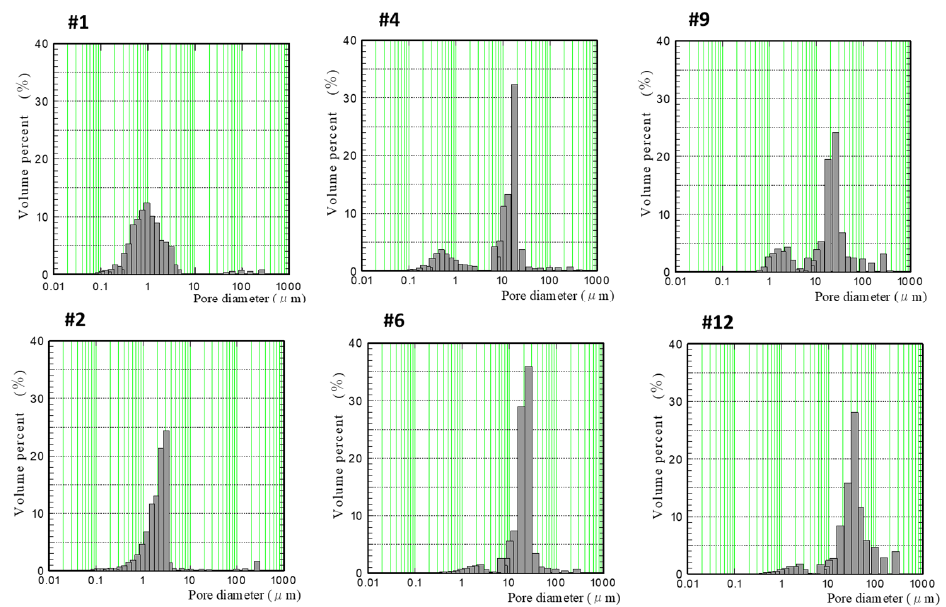
Figure 5. Distribution of pore size of PSs (#1, #2, #4, #6, #9 and #12). Values represent mean ( n =